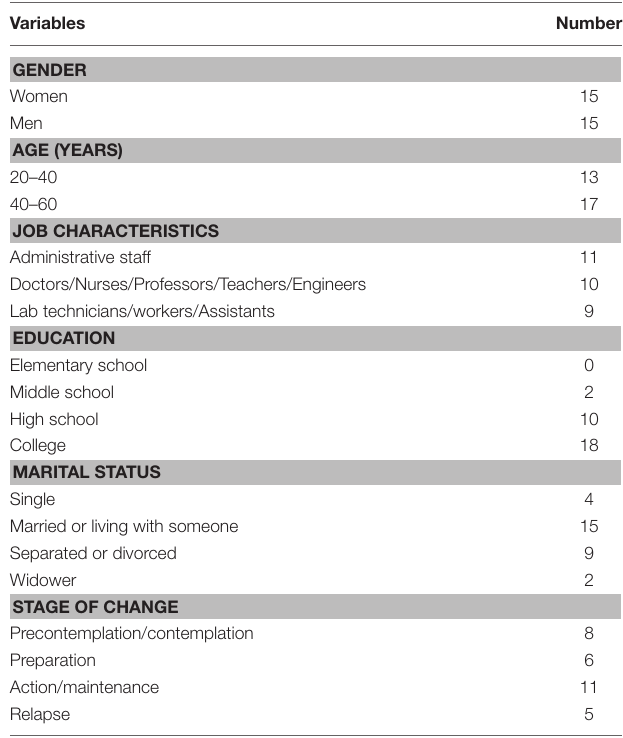
TABLE 1 | Socio-demographic and workplace characteristics among participants ( n =